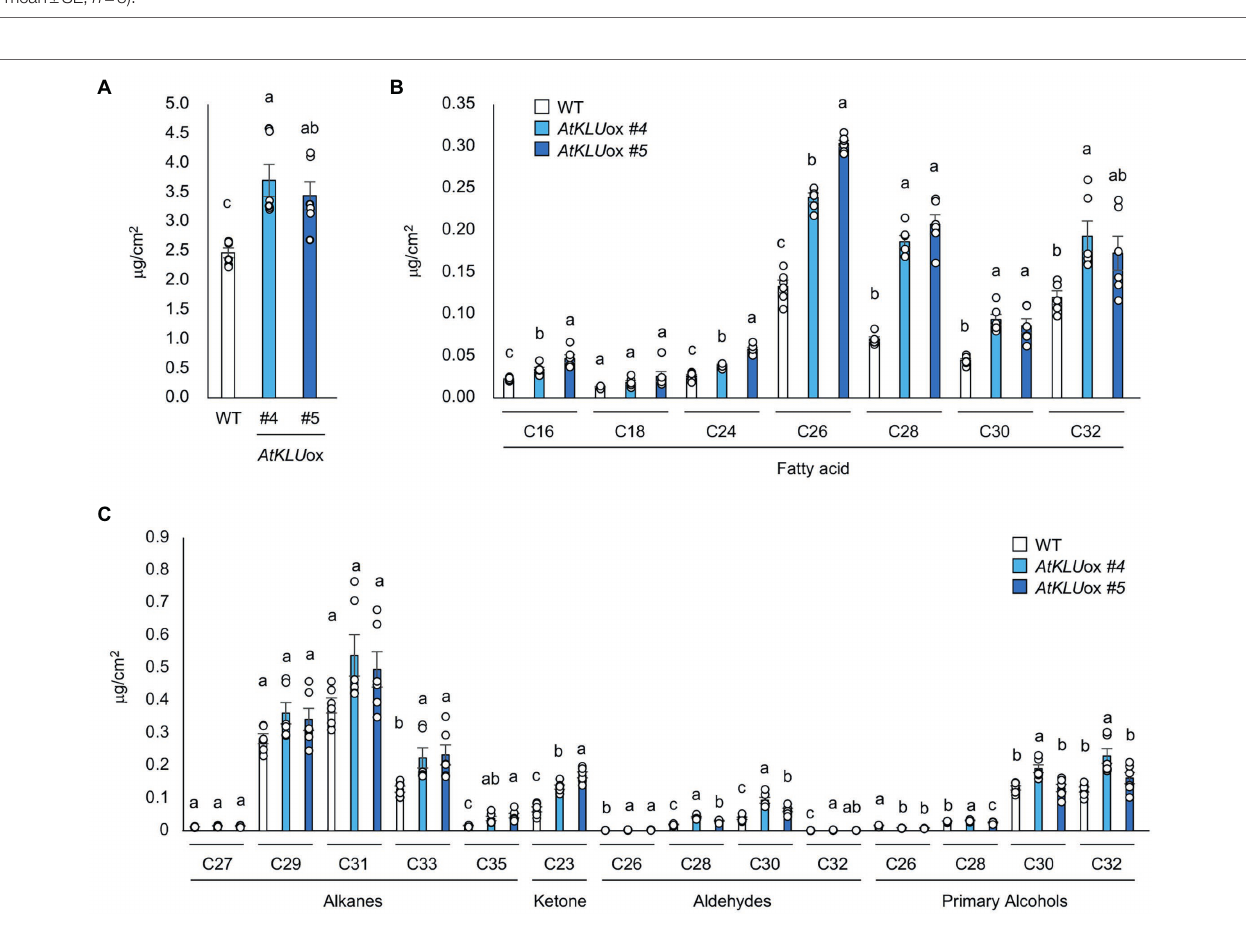
FIGURE 4 | plant material (A435) was used for normalization. Relative levels of TB were calculated as the ratio of A630:A435. Differences between WT and AtKLU ox plants were analyzed by Student’s t -test (mean ± SE, n = 3, ** P < 0.01). (C) Stem surface of WT and AtKLU ox #5 observed by scanning electron microscopy. Bars = 100 mm. (D) Water loss from detached WT and AtKLU ox leaves. The entire aerial parts of 4-week-old plants grown in soil under normal growth conditions were detached (0 min) and then left under ambient conditions for 60 min, with measurements taken every 10 min. The percentage decrease in